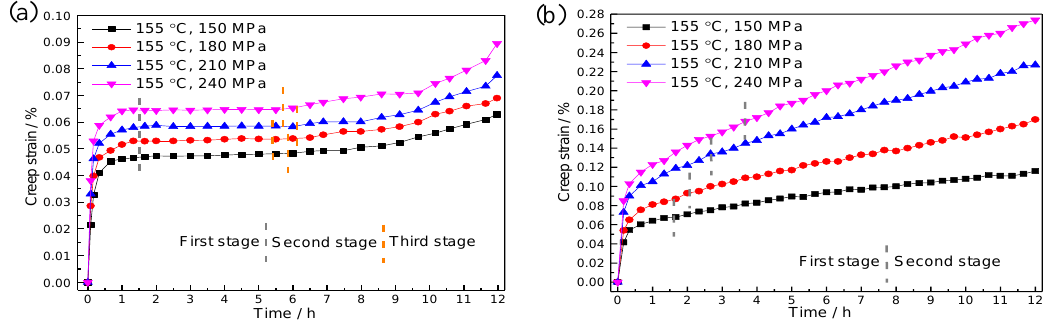
Figure 3. Comparisons of profiles for experimental creep strains of 7055 Al plate ( a ) in solid solution state and ( b ) in T6 state for 12 h under applied stress levels: 150 MPa, 180 MPa, 210 MPa, and 240 MPa.